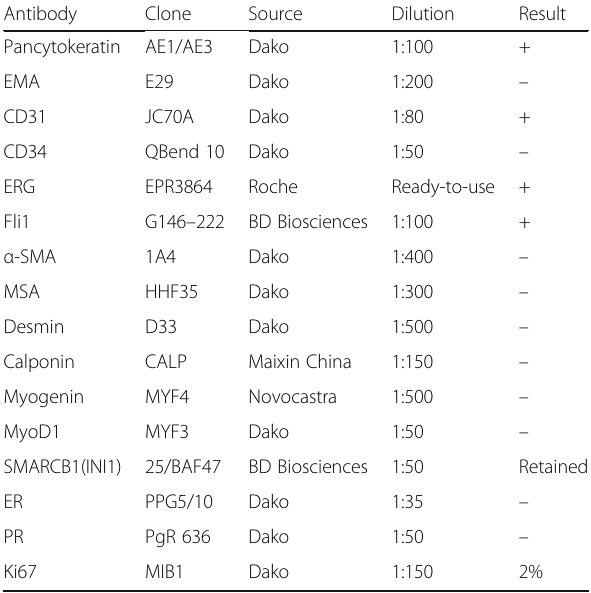
Table 1 Immunohistochemical results of pseudomyogenic